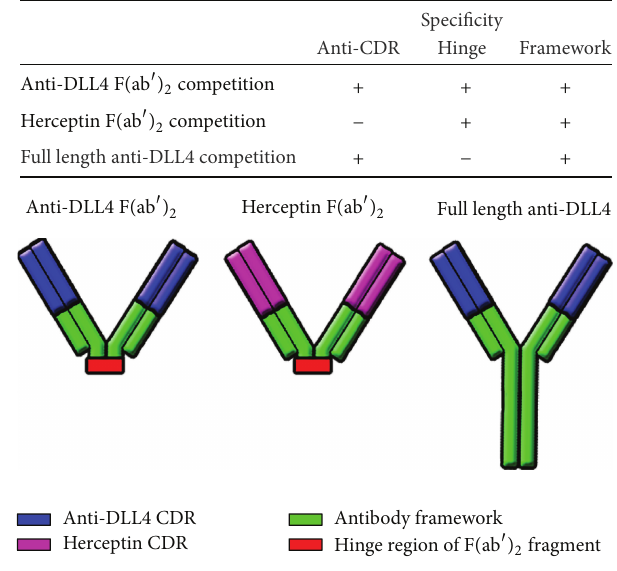
Figure 1: Specificity of signal reduction in the anti-DLL4 F(ab 󸀠 ) 2 ATA assay by different competitor molecules. Anti-DLL4 F(ab 󸀠 ) 2 competitor will reduce all reactivity in the ATA assay. Control F(ab 󸀠 ) 2 will not reduce anti-DLL4 F(ab 󸀠 ) 2 CDR reactivity